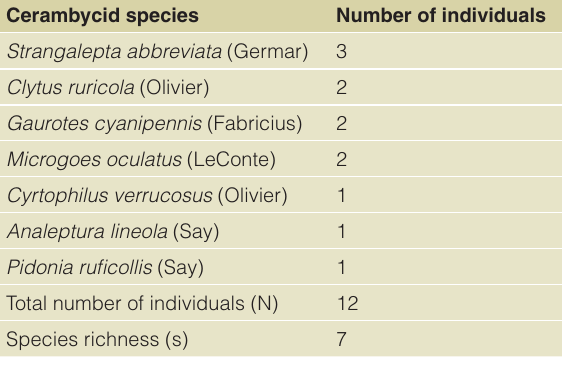
Table 4. Cerambycid (Coleoptera: Cerambycidae) Species Captured in Pearson Park, 2008 (Eastern Lucas County, OH). Total number of individuals of each species caught during the entire trapping period (early June to early October). Traps were positioned in the approximate center of each forest and all checked each week.